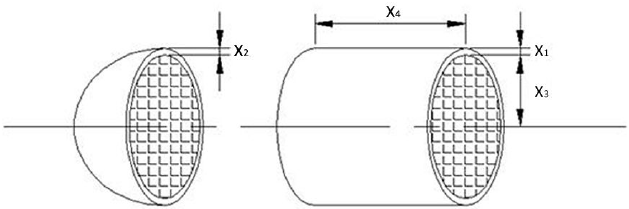
Figure 7. The Pressure Vessel Design Problem.